Question: Express in one sentence what the figure is showing.
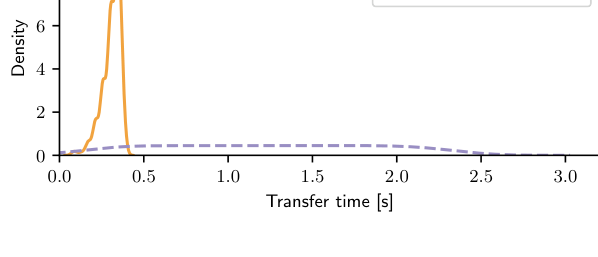
Answer: Time distribution of client’s packets of a 500 KB download.